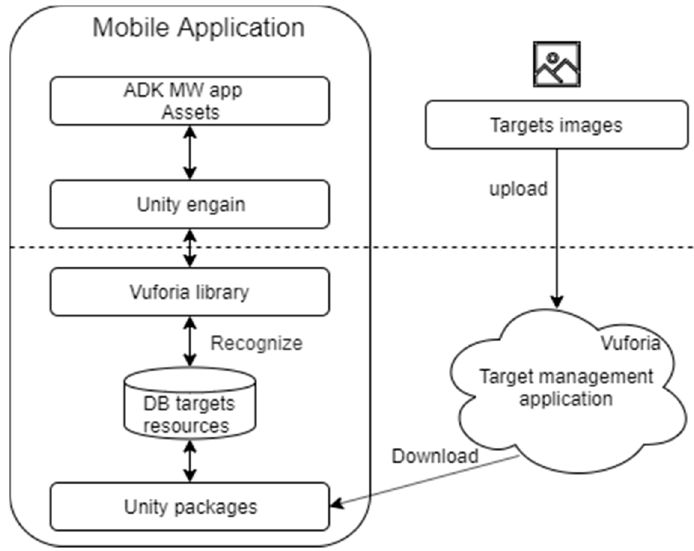
Figure 2. The architecture of the MicroWorld app.